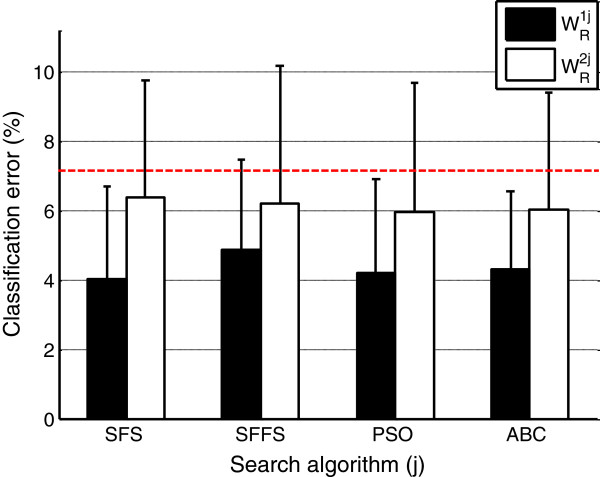
Comparison of the classification error reached with each of the eight treatment alternatives. The error bar represents one standard deviation of intersubject variability. The red line indicates the mean classifcation error obtained when the EMG patterns were classified without the iPCA transformation.